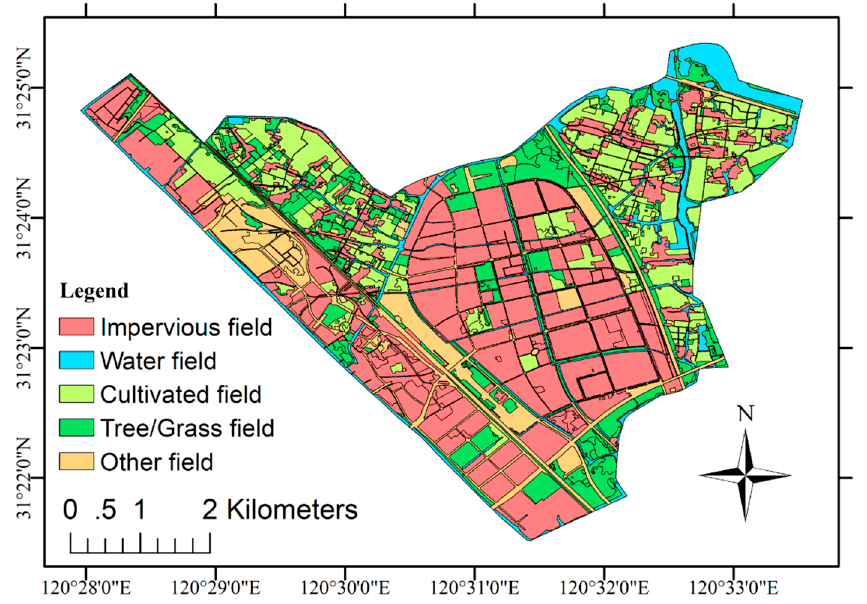
Figure 2. Historical (previous first phase, i.e., 2016) auxiliary LC map.